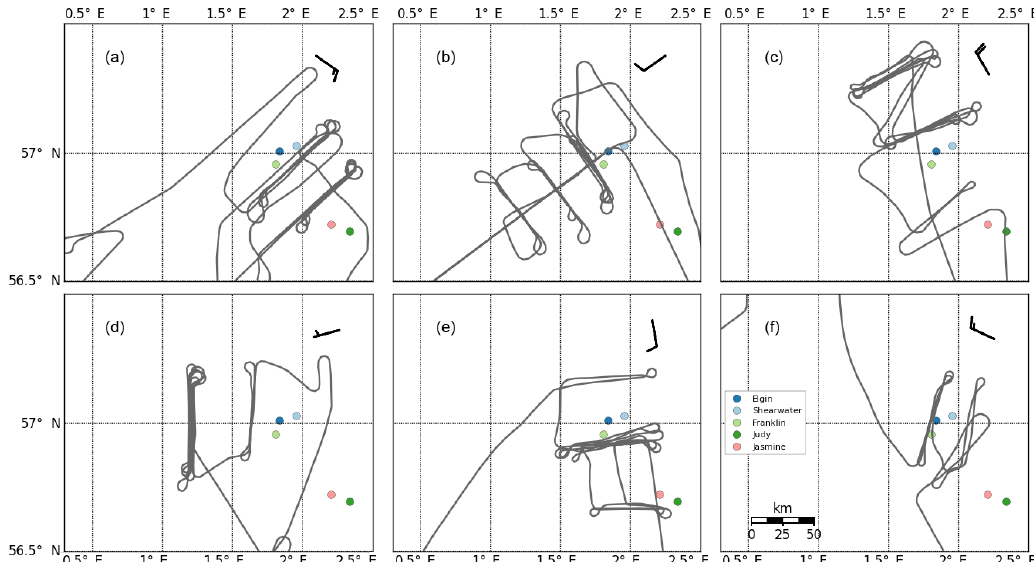
Figure 3. Flight tracks for (a) B688 – 30 March 2012; (b) B689 – 3 April 2012; (c) B690 – 17 April 2012; (d) B691 – 24 April 2012; (e) B693 – 4 May 2012; (f) B727 – 15 August 2012. The different platforms in the area (Elgin, Shearwater, Franklin, Judy and Jasmine) are shown by the different colour circles.